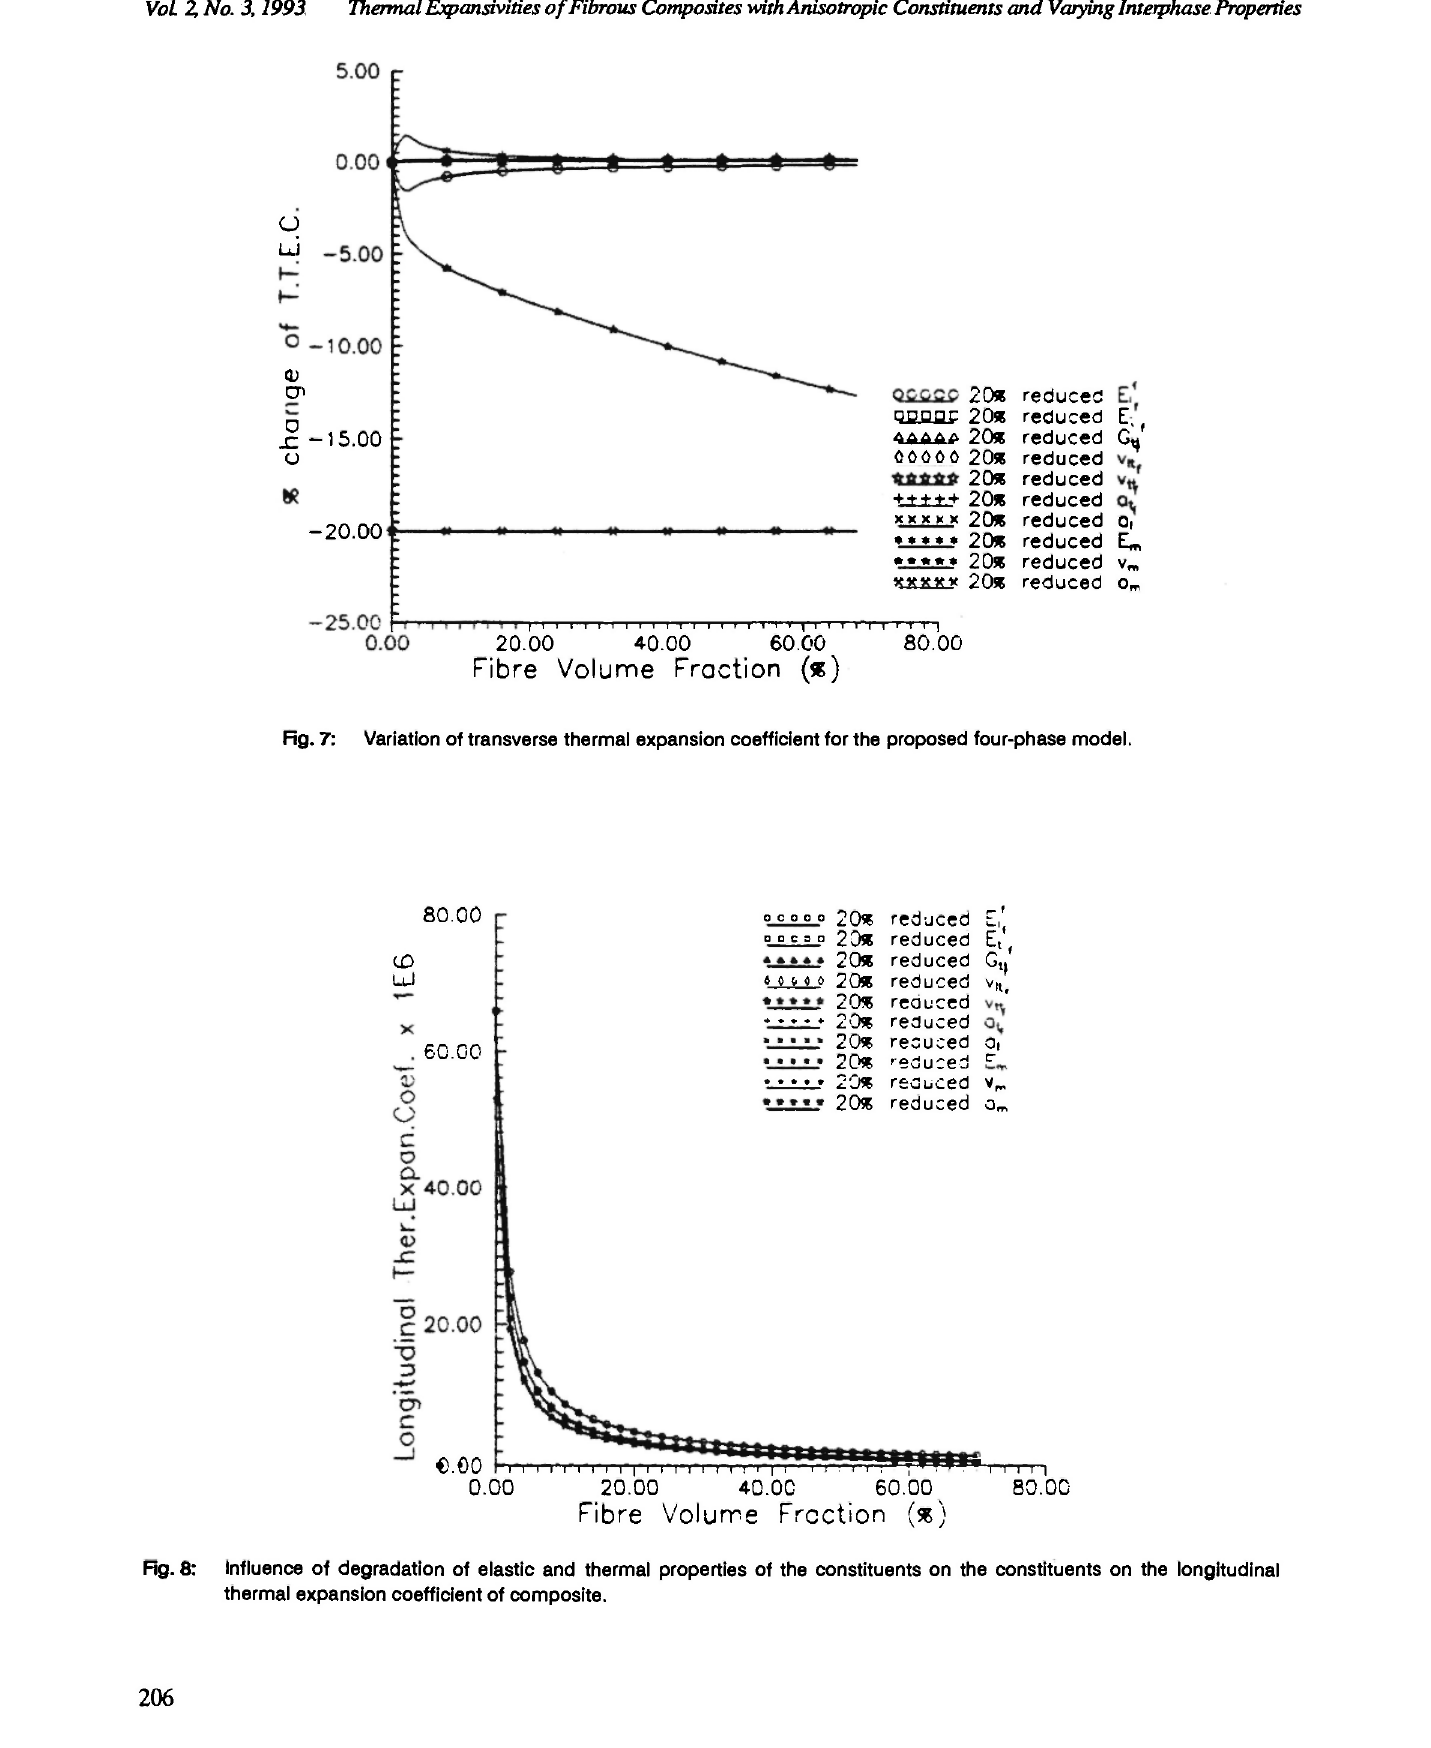
Fig. 7: Variation of transverse thermal expansion coefficient for the proposed four-phase model.